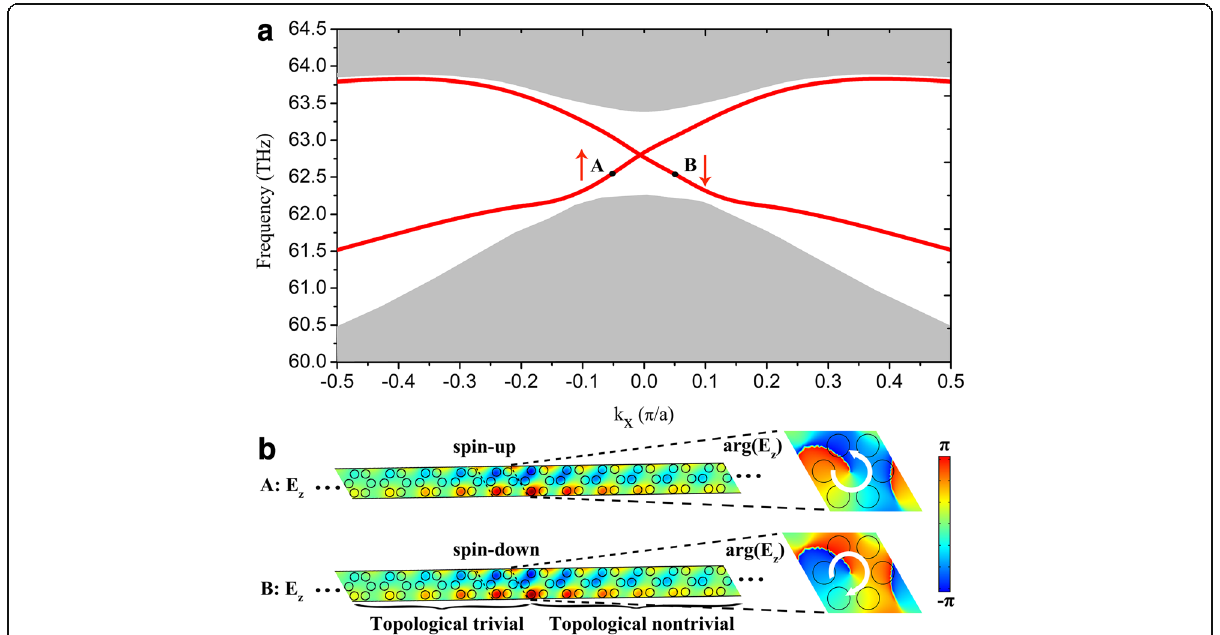
Fig. 3 a Projected band structure for a supercell composed of 16 nontrivial unit cells cladded by 12 trivial unit cells on both sides. b Electric field distributions around the interface between the trivial and nontrivial plasmonic crystals at points A and B, i.e., at k x = − 0.05 π /a and 0.05 π /a respectively